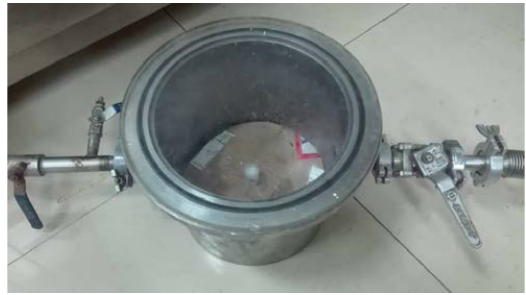
Figure 1. Vacuum tank used for eliminating air bubbles.